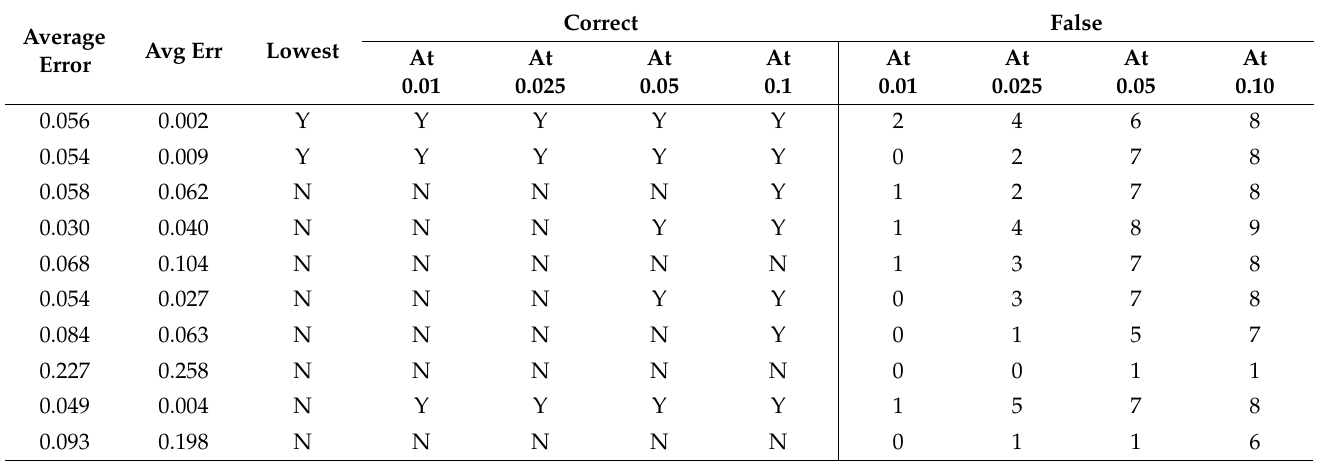
Table A184. Set 3, trials 11–20 summary data (single 0.5 PR value).